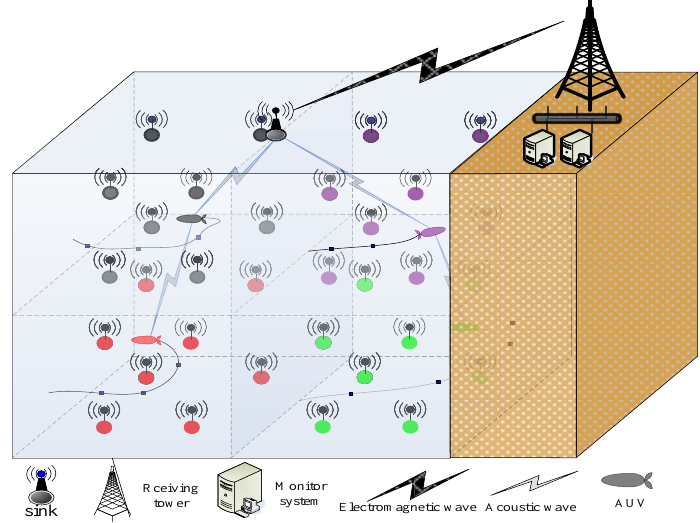
Figure 1. Underwater wireless sensor network (UWSN) system model.